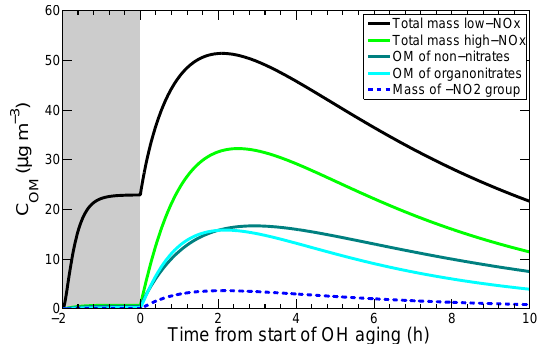
Figure 2. Organic mass concentration over 2h of dark ozonolysis followed by 10h of OH aging for low-NO x and high-NO x condi- tions. The OM for non-nitrates and organonitrates plots is under high-NO x conditions. High-NO x conditions decrease the overall organic aerosol mass produced throughout the course of a model run. At β = 0 . 15 (85% RO 2 + NO), the mass concentration of organonitrates is roughly equivalent to the mass concentration of non-organonitrates. While the contribution of the -NO 2 group itself is small, the organonitrate compounds can comprise a significant portion of the overall mass.